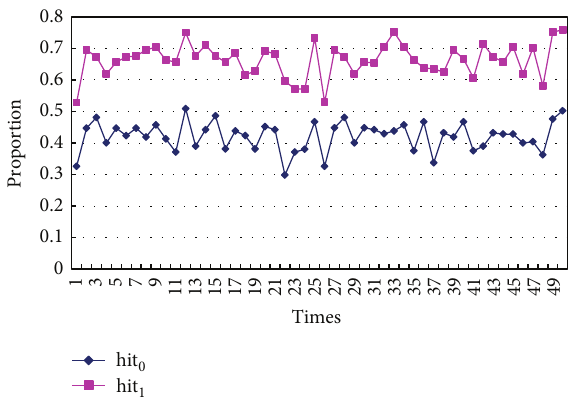
Figure 1: Performance of rough set theory. Figure 2: Solution times of ITSAR and